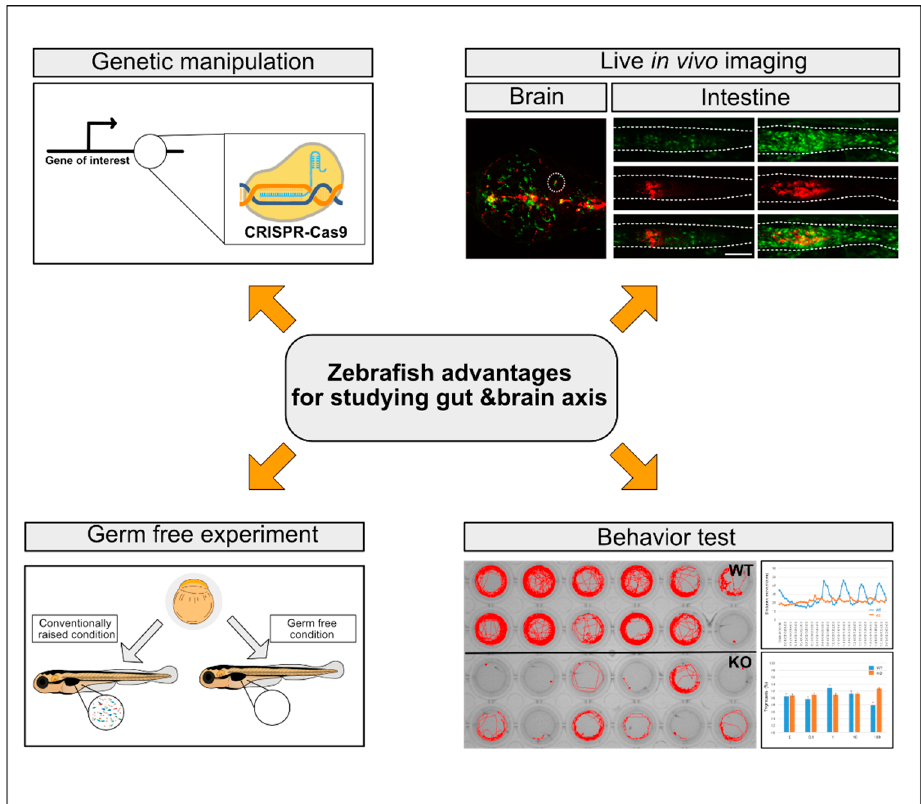
Figure 2. Key advantages of the zebrafish model for studying the MGBA. Refer to the text for de- tails.